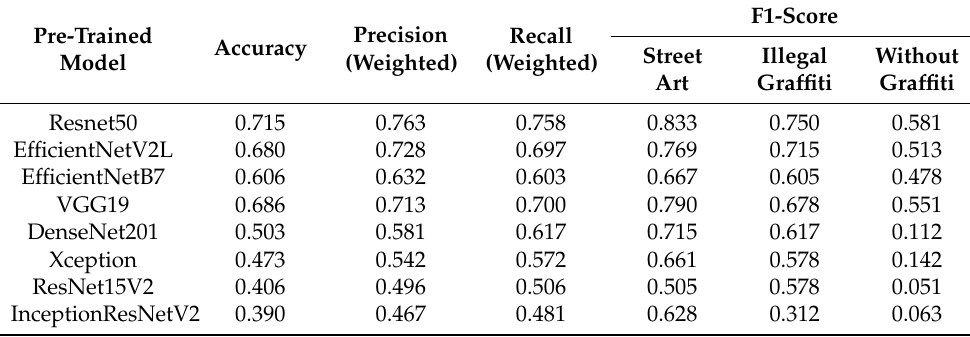
Table 4. Performance metrics achieved with different classification